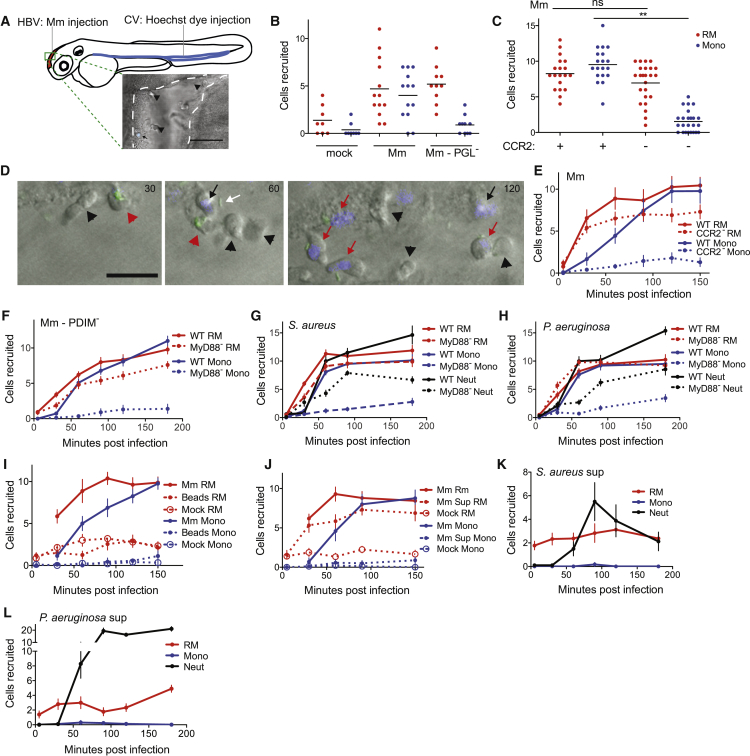
Resident Macrophages Are First Responders to Bacterial Infection(A) Cartoon of a 2 day post-fertilization (dpf) zebrafish showing the caudal vein (CV) and hindbrain ventricle (HBV) injection sites and representative image of HBV (outlined with white dashed line) with Hoechst dye negative resident macrophages (black arrowheads) and Hoechst dye positive monocyte (black arrow). Scale bar, 100 μm.(B) Mean resident macrophage (RM) and monocyte (Mono) recruitment at 3 hr post infection (hpi) into the HBV after infection with 80 wild-type Mm (Mm) or PGL-deficient Mm (Mm-PGL−). Significance testing done using one-way ANOVA, with Bonferroni’s post-test against mock injections. ∗∗p < 0.01.(C) Mean resident macrophage and monocyte recruitment at 3 hpi into the HBV of wild-type or Ccr2-deficient fish after infection with 80 wild-type Mm. Significance testing done using one-way ANOVA, with Bonferroni’s post-test for comparisons shown. ∗∗p < 0.01.(D) Representative images of uninfected resident macrophages (black arrowheads), uninfected monocytes (black arrows), infected resident macrophages (red arrowheads), infected monocytes (red arrows), and extracellular bacteria (white arrow) following infection of wild-type fish in the HBV with 80 wild-type green fluorescent Mm at 30, 60, and 120 min post infection (mpi). Scale bar, 20μm.(E) Mean resident macrophage and monocyte recruitment from 5 to 150 mpi in the HBV of wild-type or Ccr2-deficient fish after infection with 80 wild-type Mm.(F) Mean resident macrophage and monocyte recruitment from 5 to 180 mpi in the HBV of wild-type or Myd88-deficient fish after infection with 80 PDIM-deficient Mm (Mm – PDIM−).(G and H) Mean resident macrophage, monocyte, and neutrophil (Neut) recruitment from 5 to 180 mpi in the HBV of wild-type or Myd88-deficient fish following infection with 138 S. aureus (G) or 156 P. aeruginosa (H).(I) Mean resident macrophage and monocyte recruitment from 5 to 150mpi in the HBV of wild-type fish after injection with 80 wild-type Mm, 300 sterile beads, or mock injection.(J) Mean resident macrophage and monocyte recruitment from 5 to 150 mpi in the HBV of wild-type fish after infection with 80 wild-type Mm, an equivalent volume of wild-type Mm supernatant (Sup), or media mock.(K and L) Mean resident macrophage, monocyte, and neutrophil recruitment from 5 to 180 mpi in the HBV of wild-type fish after infection with S. aureus supernatant (K) or P. aeruginosa supernatant (L). (A – L) Results representative of at least three independent experiments.